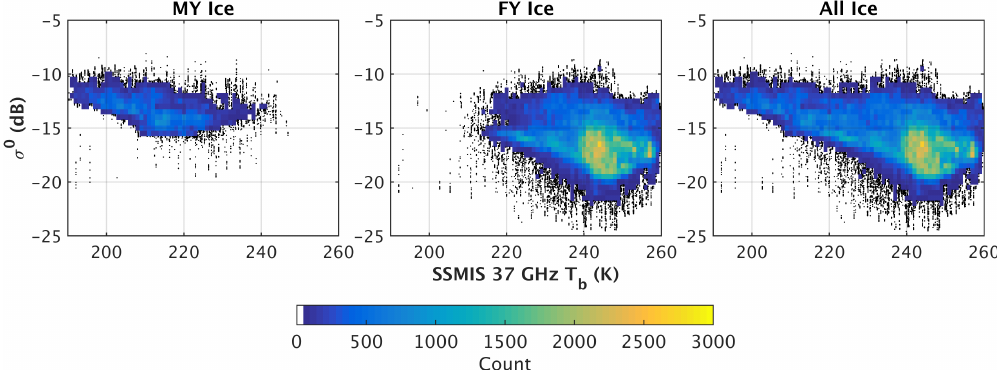
Figure 3. Joint scatterplots/2D histograms of ASCAT σ 0 values and SSMIS brightness temperatures ( T b ) for day of year 61, 2011. When the density of the scatterplot becomes too great to be able to discern individual points, the density is shown in a 2D histogram. For the 2D histogram, bin sizes are 0.5 dB by 1 K. Scatterplots/2D histograms of MY ice, FY ice, and both (all ice) are shown from left to right. The distributions of brightness temperatures and σ 0 corresponding to FY and MY ice are derived using the OSCAT ice type classifications